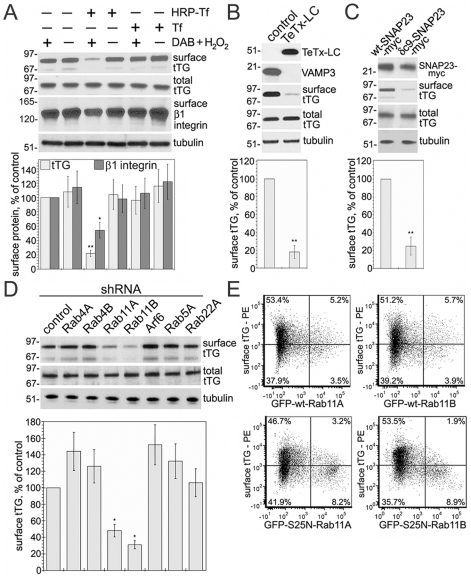
Endosome Ablation, Interference with Endosome to Plasma Membrane Fusion, and locking Rab11-Mediated Endosomal Recycling, all Inhibit tTG Externalization.(A) Functional inactivation of recycling endosomes inhibits tTG secretion. NIH3T3-tTG fibroblasts were incubated with HRP-transferrin or HRP, followed by DAB/H2O2 treatment, to ablate the recycling endosomes or lysosomes, respectively [43]. (B) Proteolysis of VAMP by Tetanus toxin inhibits tTG secretion. The light (catalytic) chain of Tetanus toxin (TeTx-LC) was expressed in NIH3T3-tTG fibroblasts. The TeTx-LC and VAMP3 levels were tested by immunoblotting. (C) Interference with SNAP23 function reduces tTG secretion. Wild type SNAP23 and its dominant negative δc9-SNAP23 mutant were expressed in NIH3T3-tTG fibroblasts as myc-tagged proteins and their levels were defined by immunoblotting. (D) Downregulation of Rab11A/Rab11B inhibits tTG secretion. shRNAs for Rab4A/B, Rab11A/B, Arf6, Rab5A and Rab22A and scrambled control were expressed in NIH3T3-tTG fibroblasts. tTG synthesis in (A–D) was induced for 4 h prior to cell surface biotinylation and isolation of surface proteins. Cell surface and total levels of tTG, β1 integrin and tubulin were defined by immunoblotting. The relative surface levels of tTG (A–D) and β1 integrin (A) were compared to those in DAB/H2O2-treated cells (A) or control transfectants (B–D). Shown in (A–D) are representative of three independent experiments. Bars show means ± SEM, *p<0.05, **p<0.005. (E) Interference with GTPase activity of Rab11 decreases tTG externalization. NIH3T3-tTG fibroblasts were transfected with wild type Rab11A, Rab11B, or their S25N dominant negative mutants fused to GFP. 48 h later the transfectants were induced to synthesize tTG for 4 h and live cells were stained at 4°C for surface tTG. Two-color flow cytometry of surface tTG (phycoerythrin) and transfected Rab11 proteins (GFP) levels is shown for gated live transfectants. Note a reduction in surface tTG levels in the transfectants that express high levels of Rab11A and Rab11B dominant negative mutants (right quadrants). Shown is representative of four independent experiments.